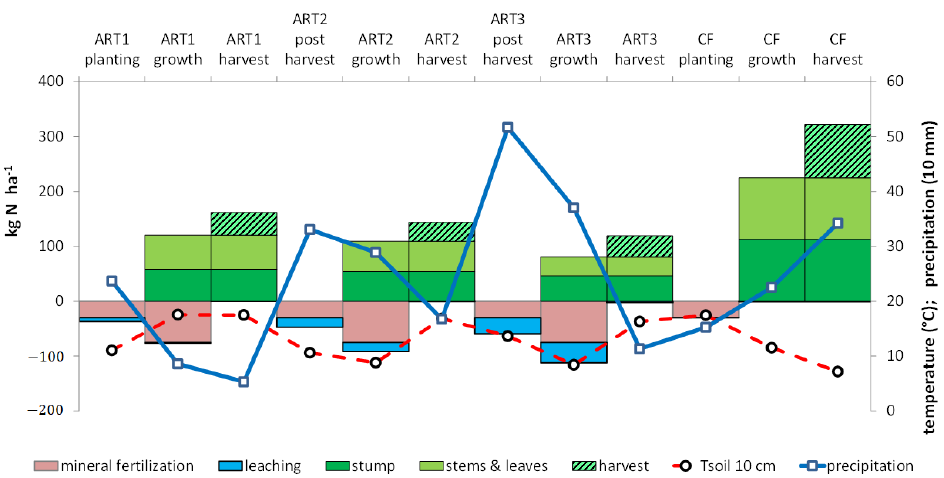
Figure 2. Change in mean soil temperature (Tsoil 10 cm), precipitation, N fertilization, uptake and leaching during the artichoke (ART)–cauliflower (CF) rotation.